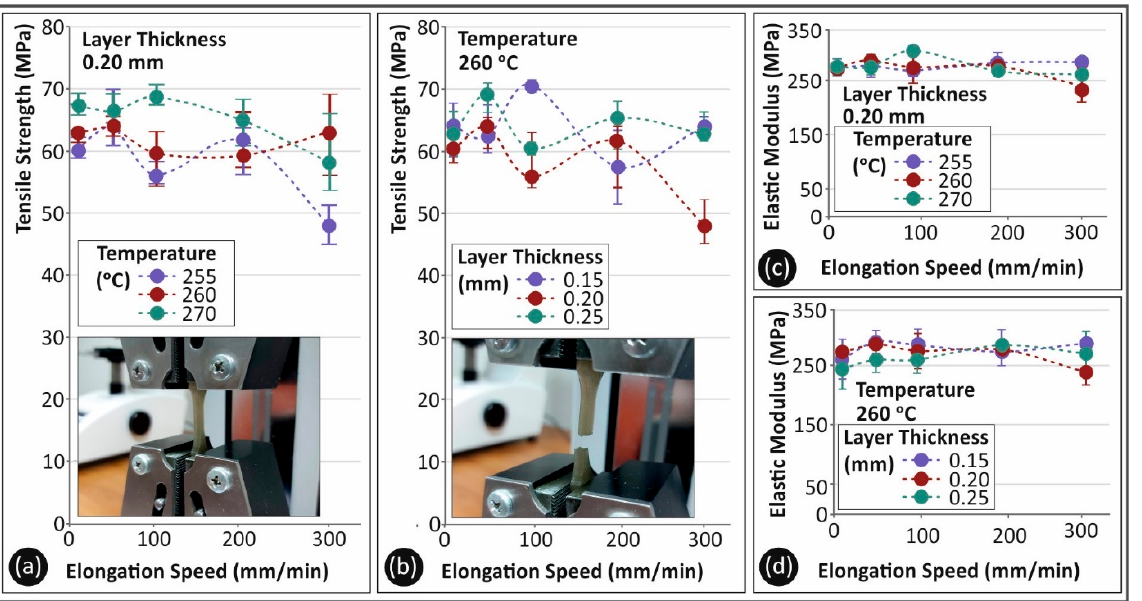
Figure 5. ( a , b ) Average tensile strength (MPa) and ( c , d ) average tensile elastic modulus (MPa) to elongation speeds (mm/min) for PC material as follows: ( a , c ) 3D printing temperatures; ( b , d ) layer heights.